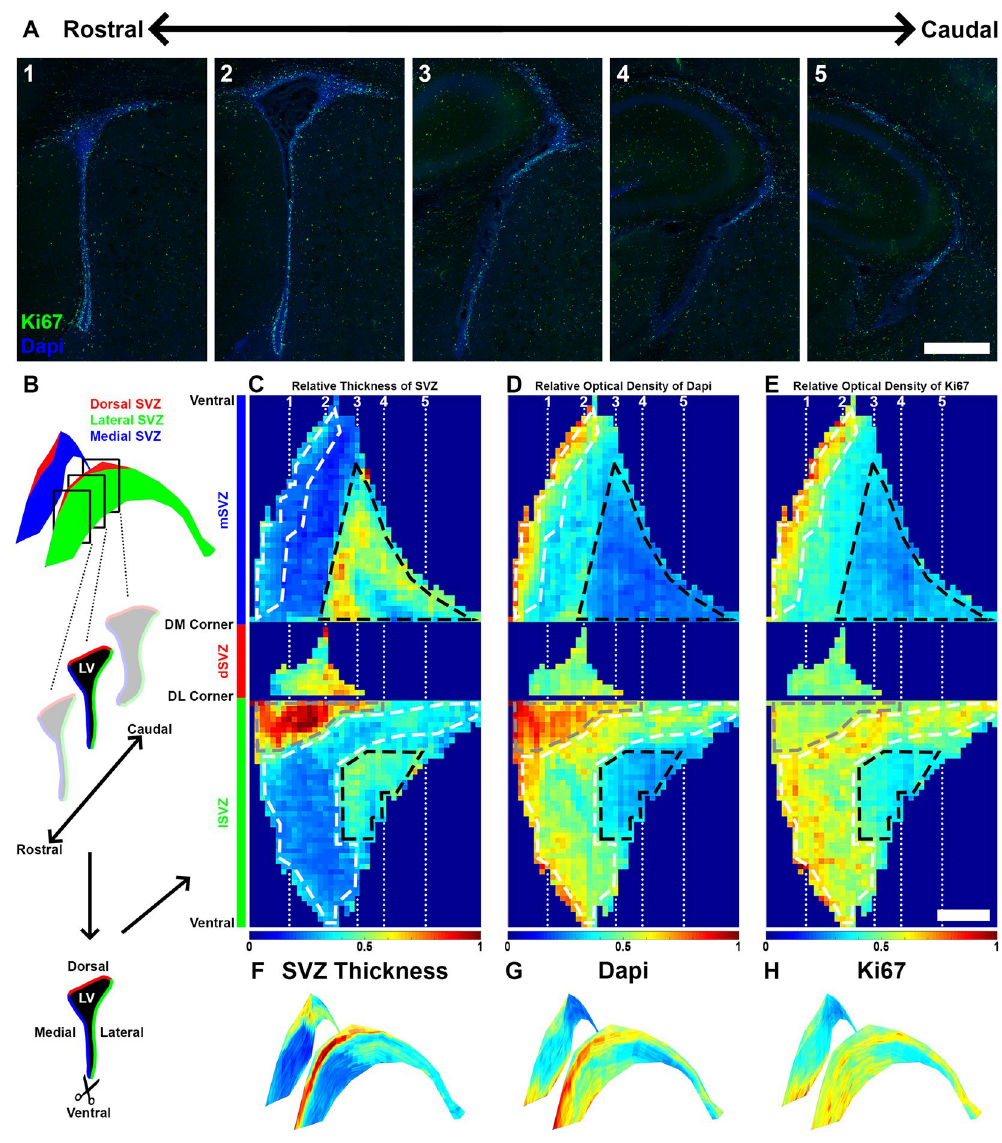
Figure 4. “FlashMap” reveals major differences in SVZ thickness, cellular density and germinal activity throughout the SVZ. (A) Representative micrographs of the proliferation marker Ki67 (green) at distinct rostro- caudal SVZ coordinates (Dapi, blue). (B) Schematic representation of sections and heatmaps orientations. The LV is cut open (scissors) at its most ventral tip between the mSVZ (blue) and the lSVZ (green). This allows unfolding the three SVZ walls for optimal 2D heatmap representations (see C – E ). (C–E) Heatmaps of the relative thickness of the SVZ ( C ) and of relative ODs for Dapi ( D ) and Ki67 ( E ) along the full rostro-caudal extent of the LV (left = rostral; right = caudal). White dashed boxes underline regions of maximal germinal activity, while black dashed boxes underline regions of minimal germinal activity. Note the differences existing between these regions in term of SVZ thickness and cellular density. The location of the RMS is highlighted with a grey dashed box. The heatmap colour code goes from 0 (deep blue) to maximal detected thickness/OD 1 (deep red). (F–H) 3D projections on the LV of heatmaps for relative SVZ thickness ( F ) and relative ODs for Dapi ( G ) and Ki67 ( H ). Scale bars: (A,E) = 500 µ m. Abbreviations: SVZ, subventricular zone; lSVZ, lateral subventricular zone; dSVZ, dorsal subventricular zone; mSVZ, medial subventricular zone; LV, lateral ventricle; DM corner, dorso-medial corner; DL corner, dorso-lateral